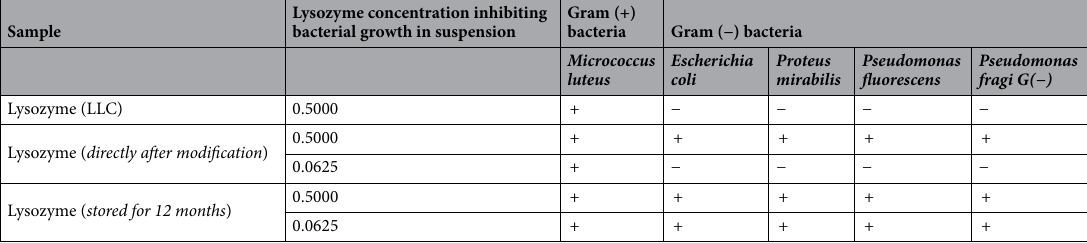
Table 1. Microbiological test of lysozyme antibacterial activity against selected gram-positive (+) and gram- negative (−) bacteria.